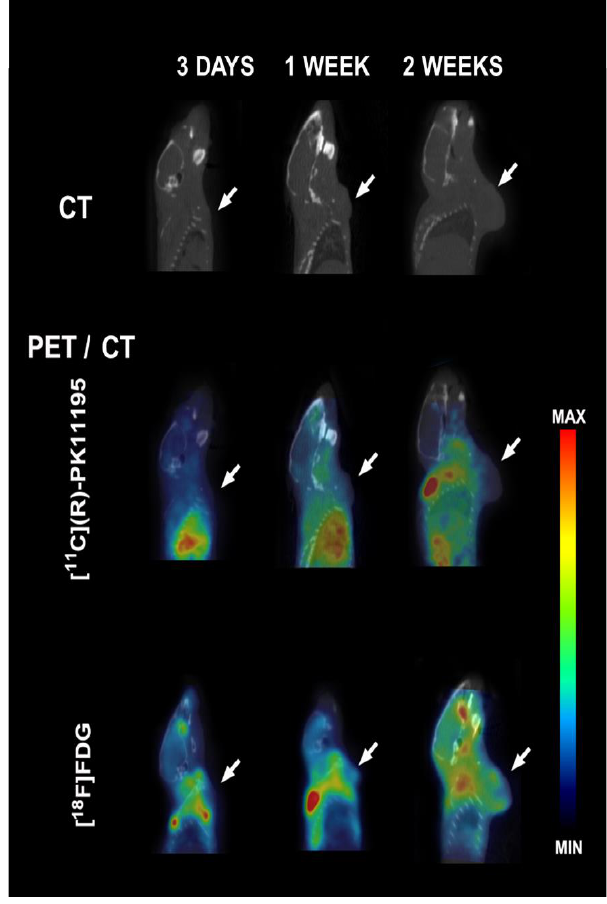
Figure 3. Illustrative [ 11 C]( R )-PK11195 and [ 18 F]FDG PET images fused with anatomic reference (CT image). The white arrows indicate the tumor site. Figure 4 represents the tumor uptake of [ 11 C]( R )-PK11195 (A) and [ 18 F]FDG (B) at 3 days, 1 week, and 2 weeks after 4T1 cell inoculation.